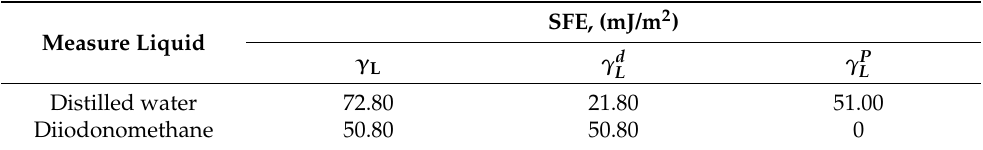
Table 2. The values of surface free energy (SFE) and their components for distilled water and diiodonomethane used in the Owens–Wendt method